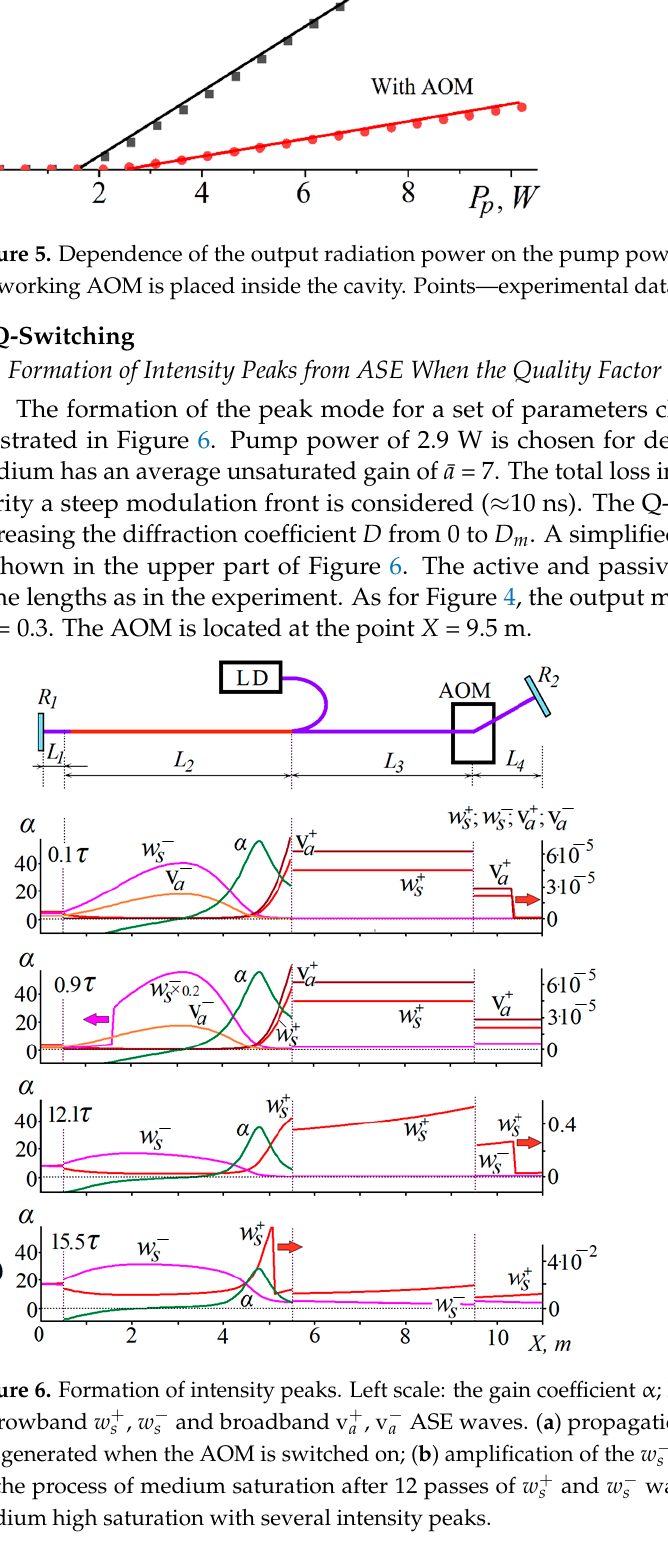
intensity 𝑤 (cid:3043)(cid:2879) ).